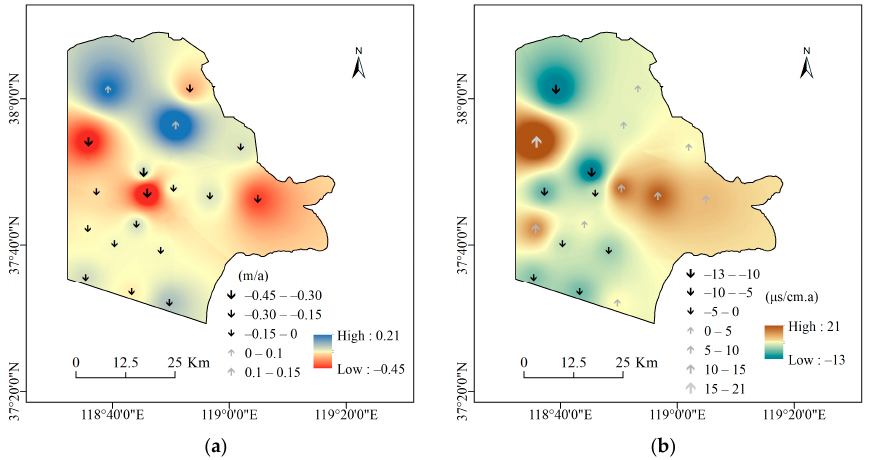
Figure 3. The distributional maps of the developing trends of groundwater: ( a ) GWL; ( b )EC.